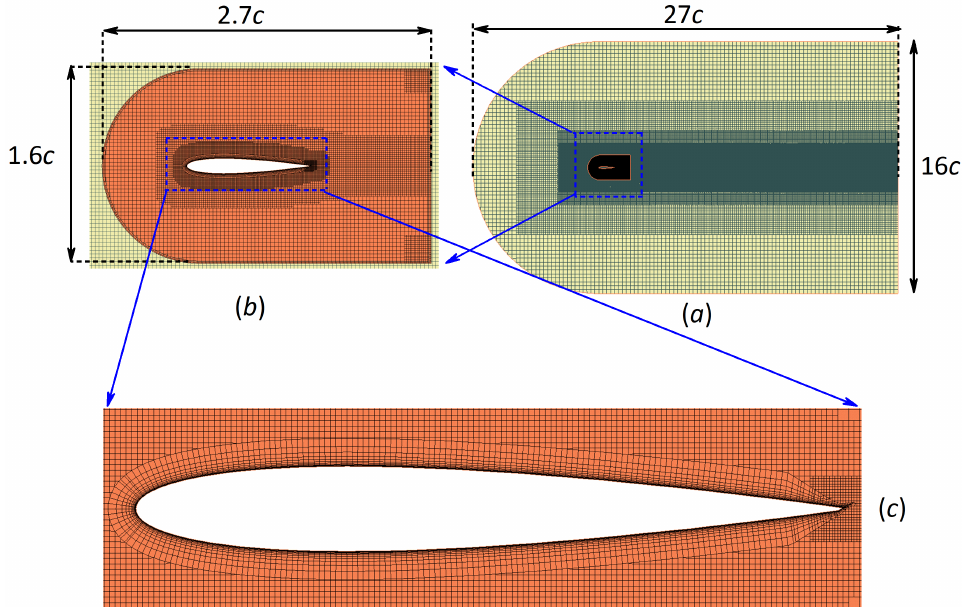
Figure 2. Computational domain and mesh structures. ( a ) Grid of the computational domain with boundaries. ( b ) Close-up view of Grid around overset mesh. ( c ) Close-up view of grid around the hydrofoil.